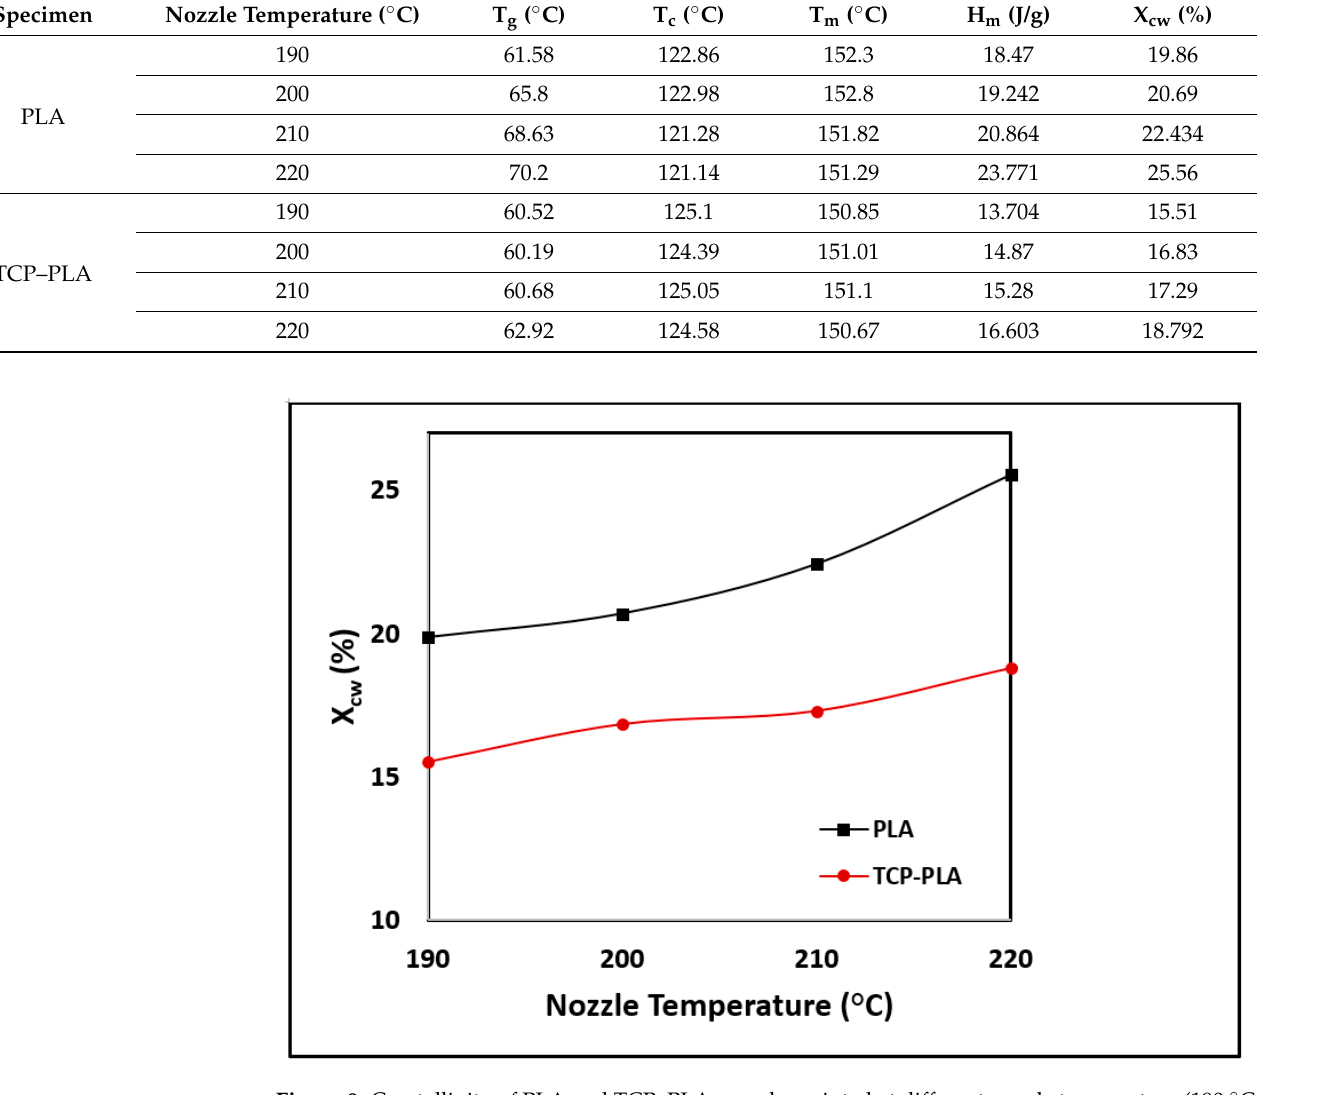
Figure 9. Crystallinity of PLA and TCP–PLA samples printed at different nozzle temperature (190 °C, 200 °C, 210 °C, and 220 °C).